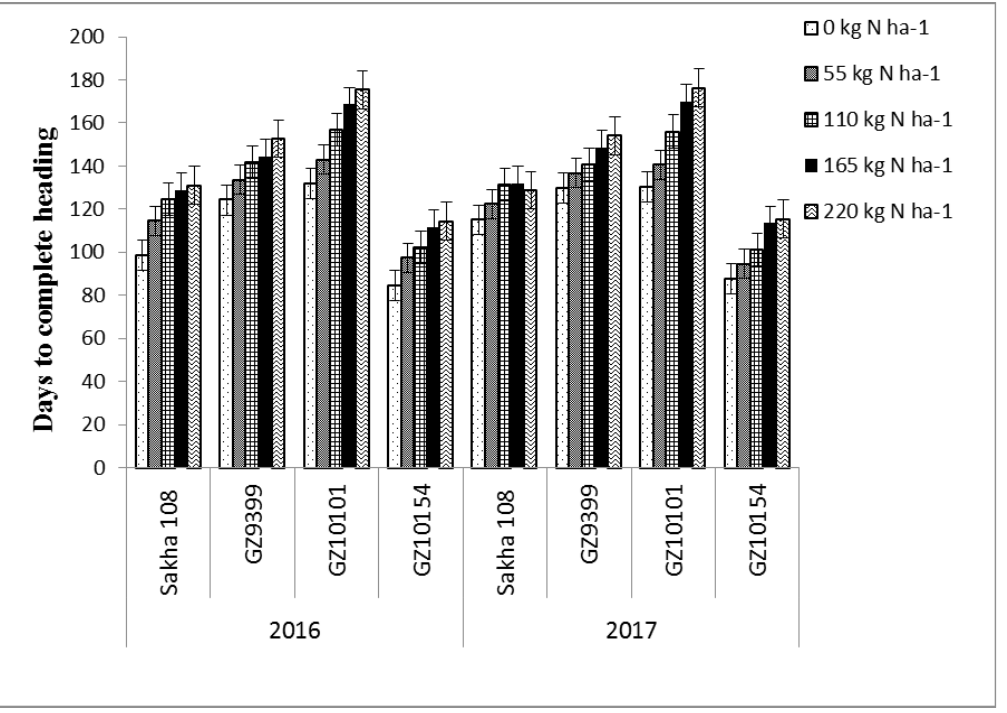
Figure 1: Days to complete heading as affected by interaction between rice genotypes and N levels in 2016 and 2017 seasons. Vertical bars represent ±standard error ( SE , n=4)